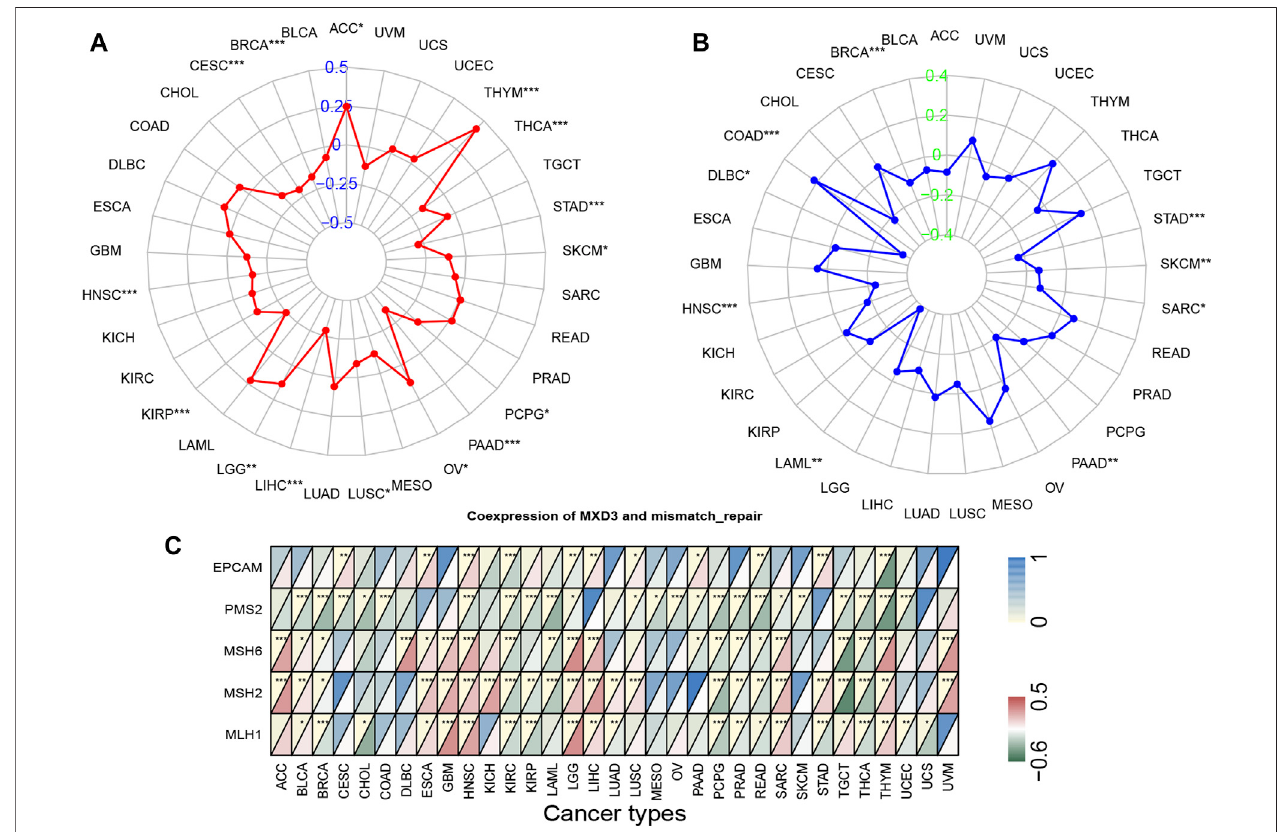
FIGURE 9 | TMB (A) , MSI (B) , and mismatch repair genes (C) correlated with MXD3